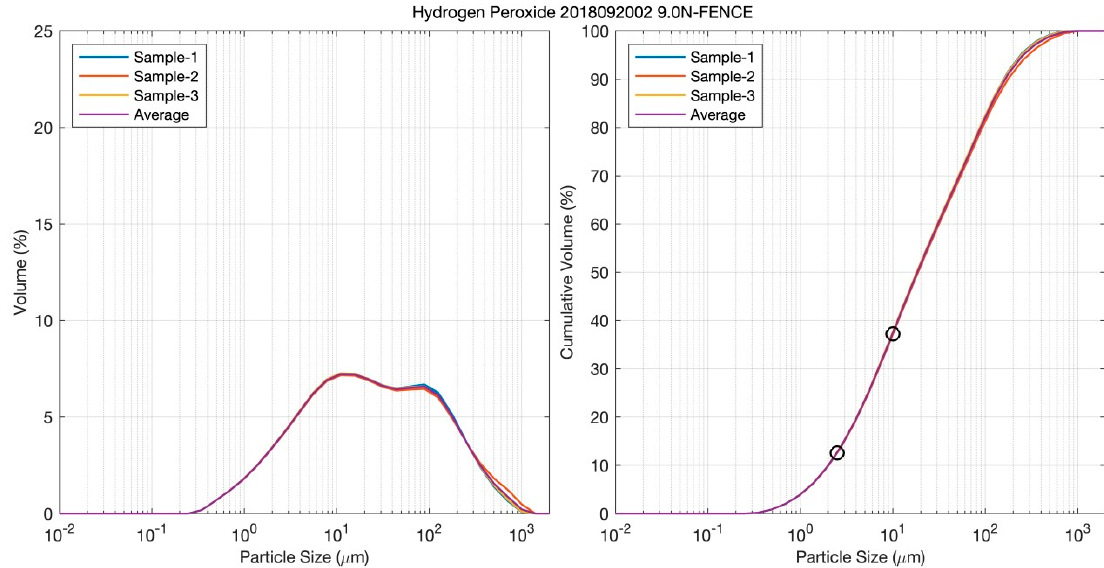
Figure 5. Grain size distribution of the soil at the North Playa field.